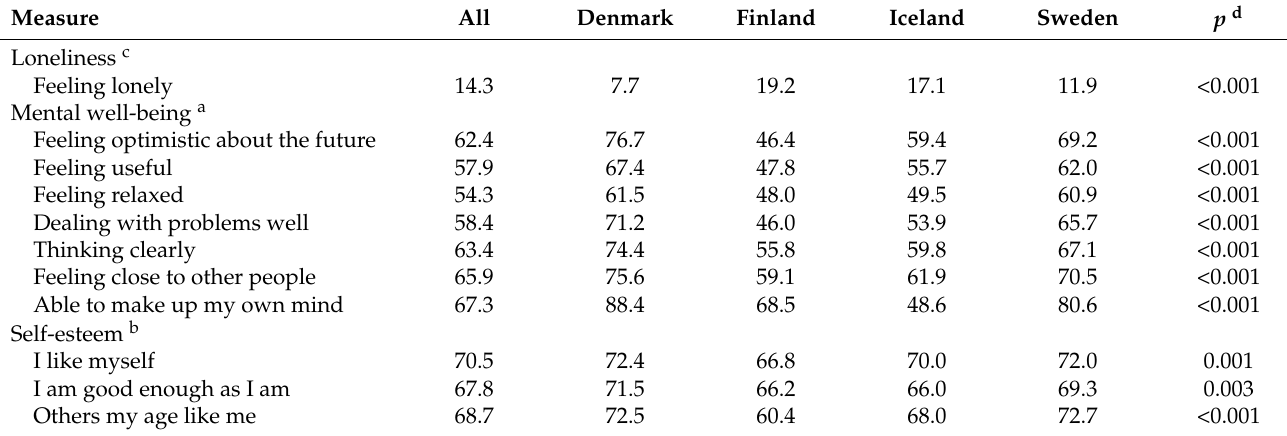
Table 1. Prevalence of loneliness, positive mental health, and high self-esteem in Denmark, Finland, Iceland, and Sweden ( n = 5717 to